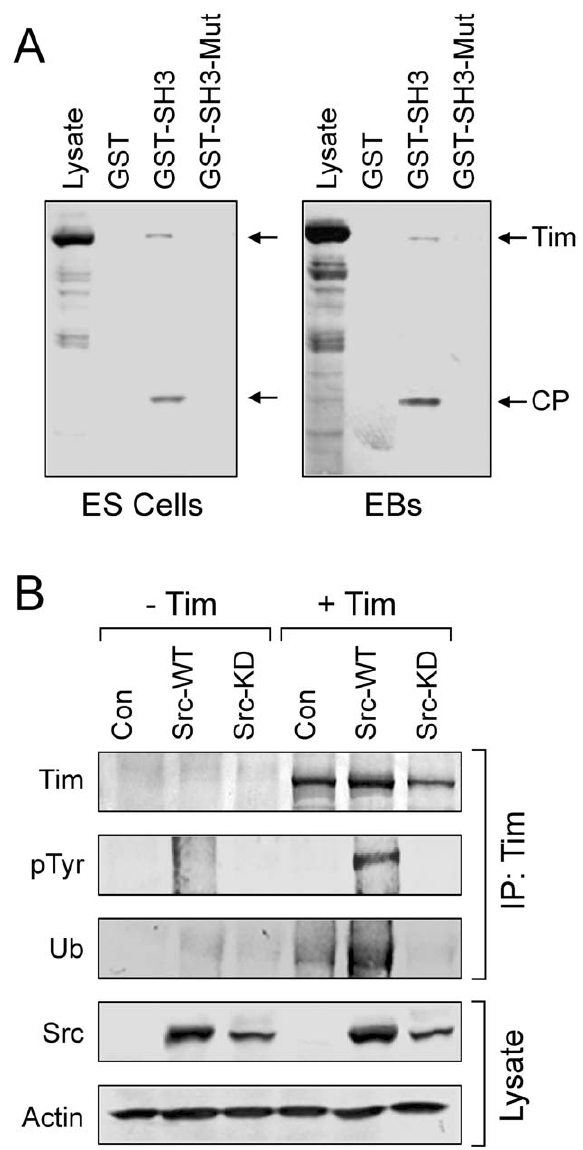
Figure 2. Tim is a c-Src SH3 domain binding protein and substrate. A , Lysates were prepared from ES cells and EBs and incubated with immobilized GST, the Src GST-SH3 fusion protein, or the corresponding inactive GST-SH3 mutant. Following washing, bound proteins were separated by SDS-PAGE, transferred to PVDF membranes and probed with an anti-peptide antibody to Tim. Full-length Tim and a discrete cleavage product (CP) were found to associate with the GST- SH3 fusion protein, but not with GST alone or with the mutant GST-SH3 domain. B , Tim is a substrate for c-Src. Human 293T cells were transfected wild-type c-Src (Src-WT), a kinase-defective mutant (Src-KD), or with the empty expression plasmid (Con) together with V5 epitope- tagged mouse Tim as indicated. Tim was immunoprecipitated from the transfected cell lysates with a V5 antibody and immunoblotted for Tim protein recovery (Tim), tyrosine phosphorylation (pTyr), and ubiquitin (Ub). Tranfected Src protein expression was confirmed in the cell lysates, with actin as a loading